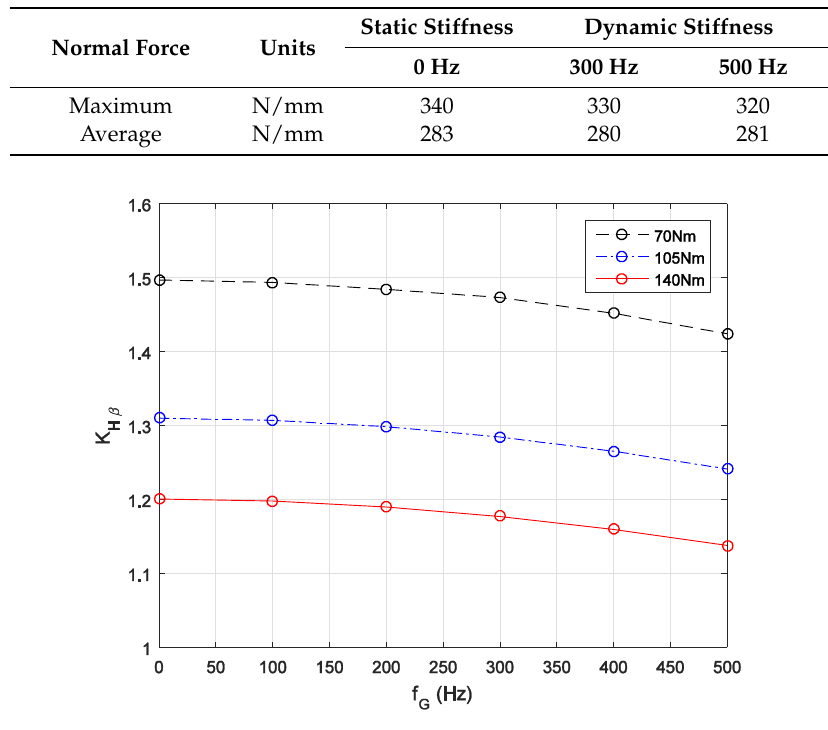
K , in relation to torque and gear mesh frequency. Figure 10. Face load factor, Figure 10. Face load factor, K H β , in relation to torque and gear mesh  H